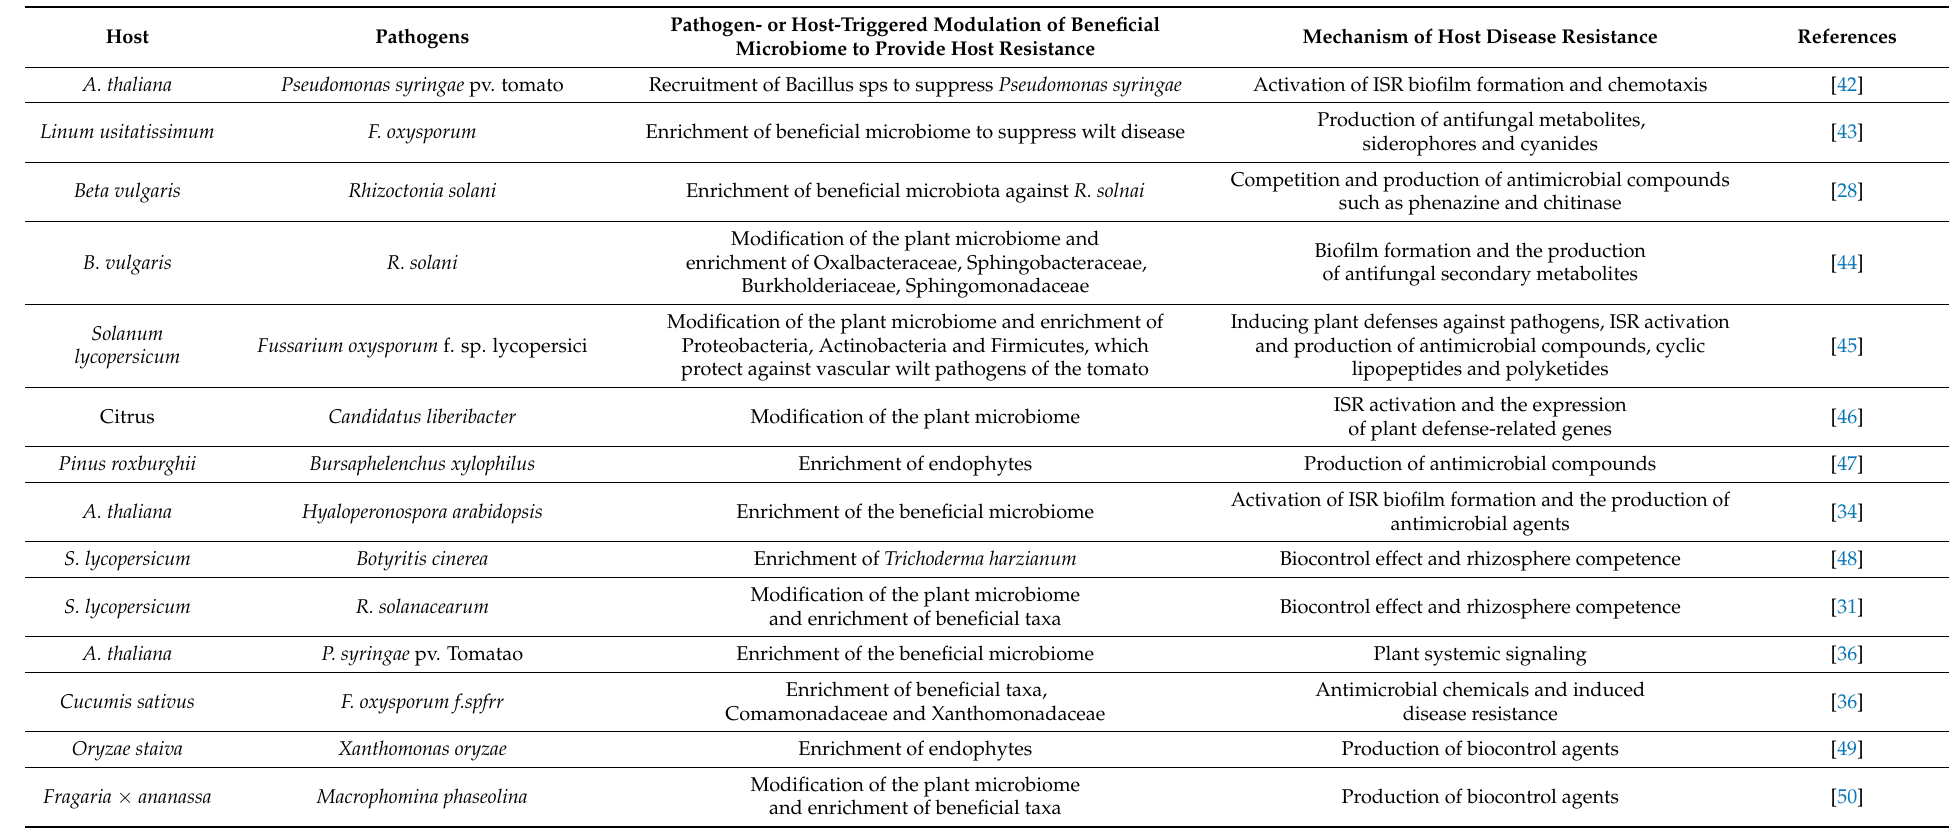
Table 1. Shows the role of plant beneficial microbiome in plant disease